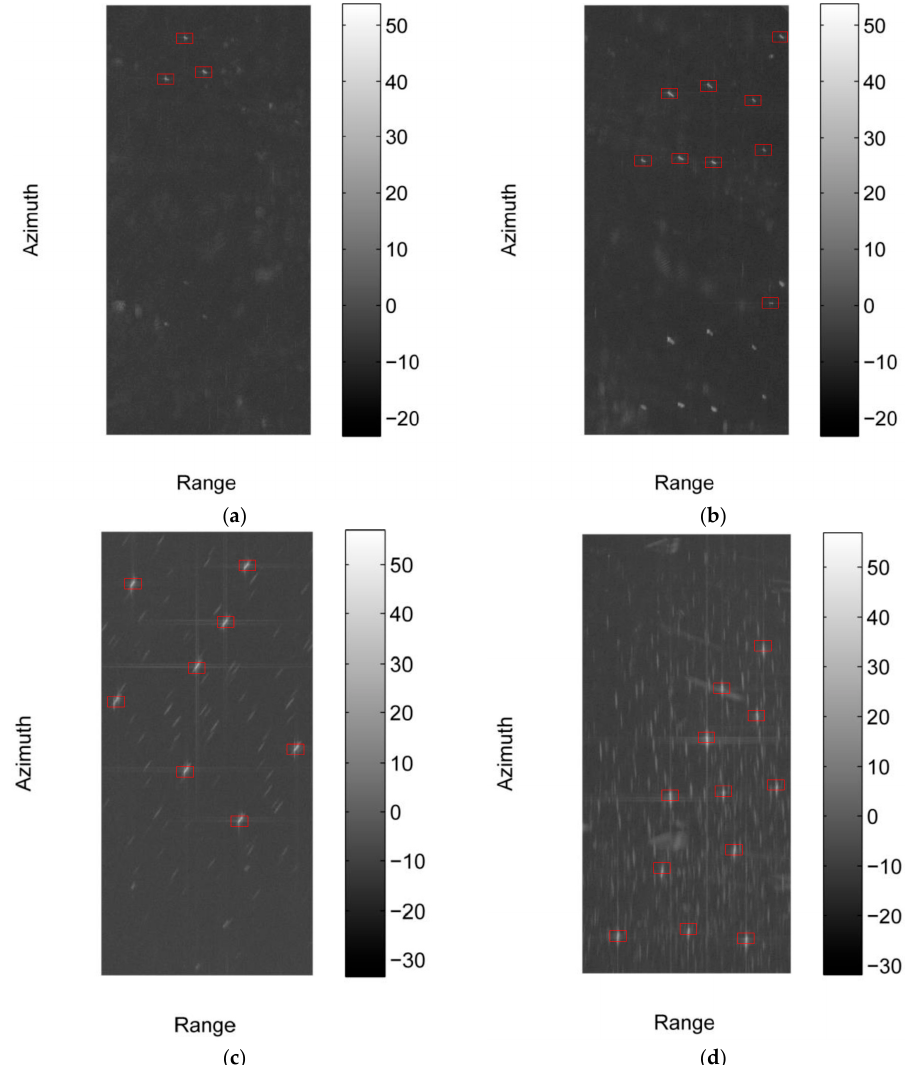
Figure 7. Detected results of the proposed method on sub-image #1 to #4, and the intensities of these images in dB are shown in the figure. ( a ) Detected result of sub-image #1; ( b ) Detected result of sub-image #2 ( c ) Detected result of sub-image #3; ( d ) Detected result of sub-image #4.